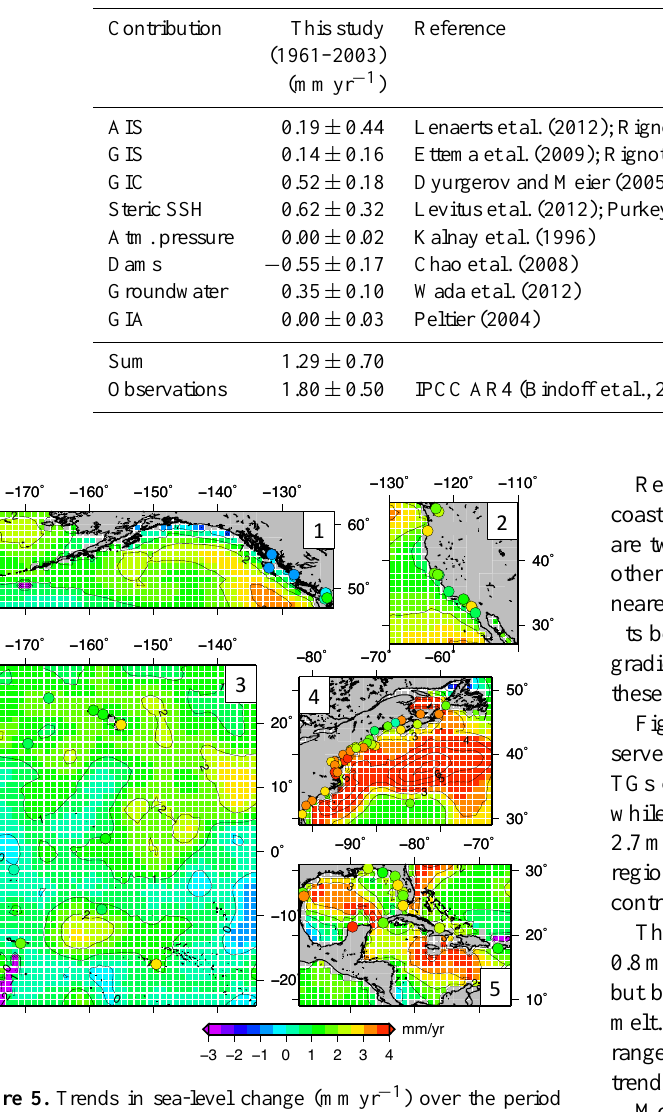
Table 2. Global mean sea-level trends (mmyr − 1 ± 1 σ ) of the various contributions for 1961–2003; compared to Church et al. (2011) trends for 1971–2008, as discussed in Sect. 4.2.